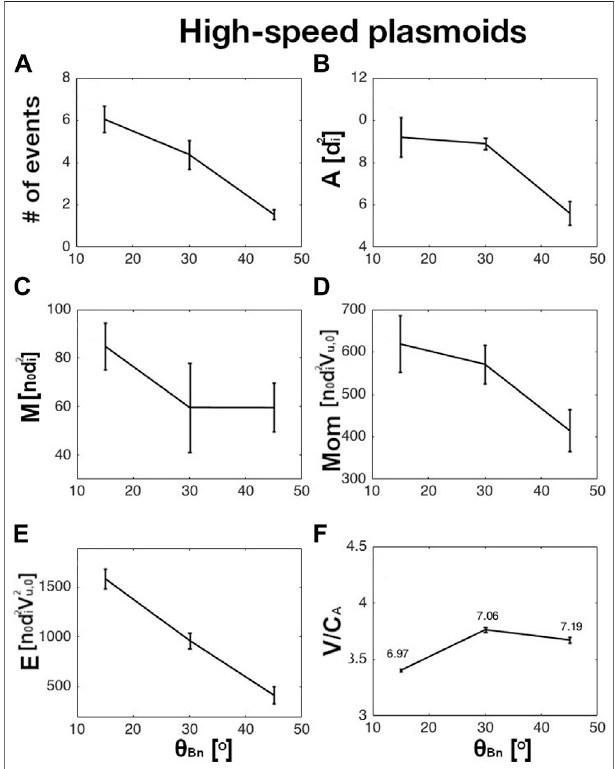
FIGURE6| Averagepropertiesofhigh-speedplasmoidsasafunctionof θ BN . Figure format is the same as in Figure 3 . The units are given in brackets. The subindex u refers tothe upstream region, while the subindex 0 means the initial